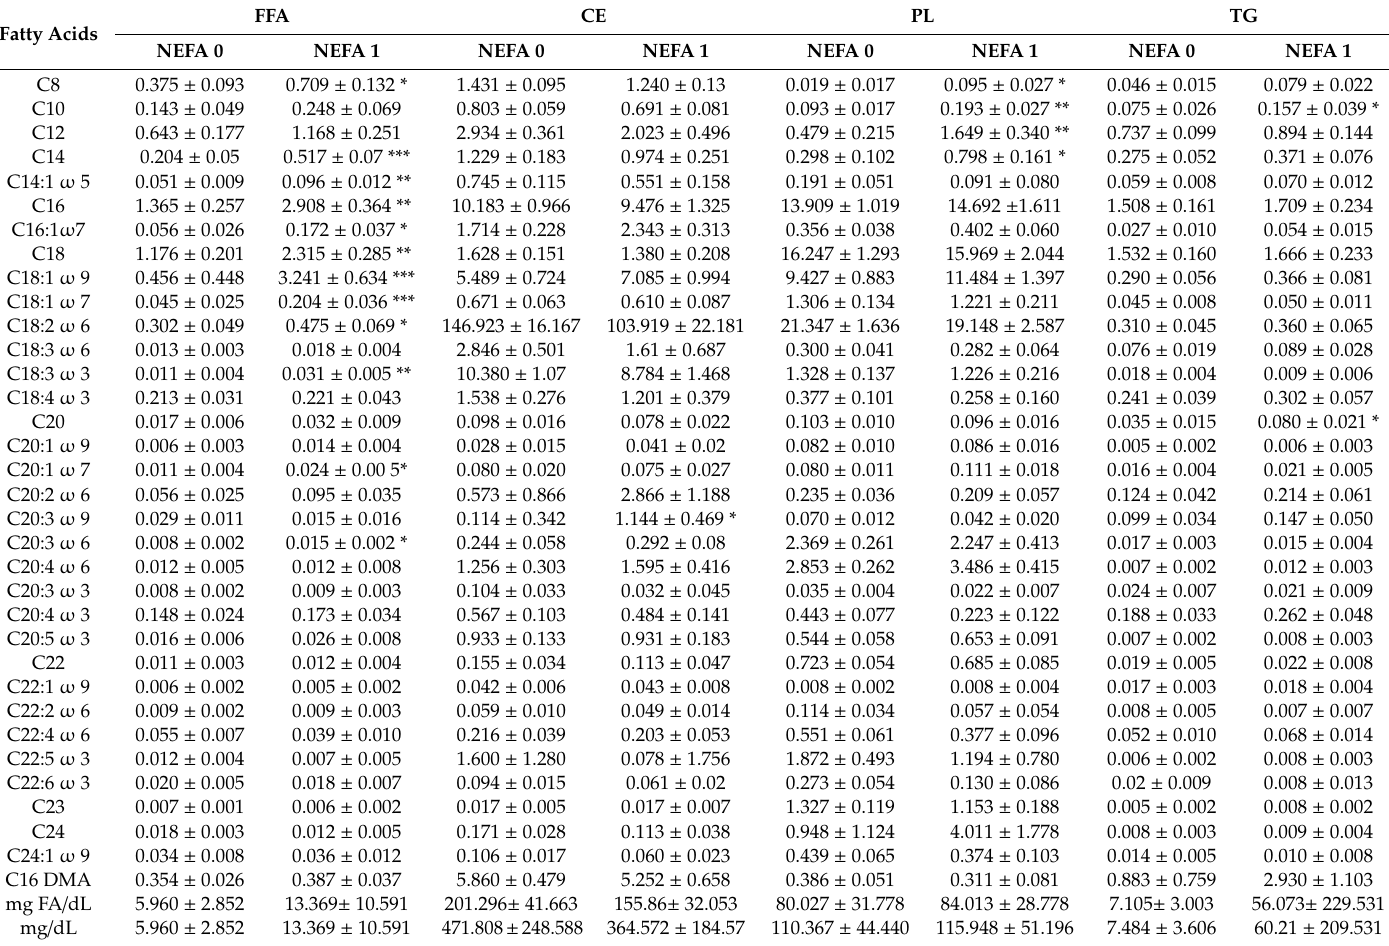
Table 2. Mean value of plasma fatty acids ( ± SD) relating to the lipid class of free fatty acids (FFAs), cholesterol esters (CE), phospholipids (PL) and triglycerides (TG) in relation to two classes of NEFA